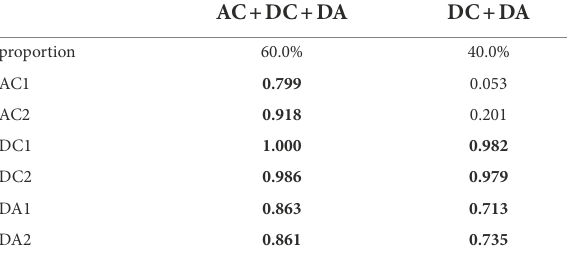
TABLE 3 Conditional probabilities and group proportions of two observed latent groups. AC + DC + DA DC +